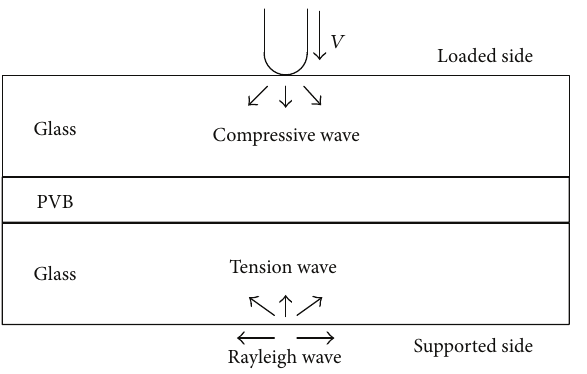
Figure 8: The propagation process of stress waves.